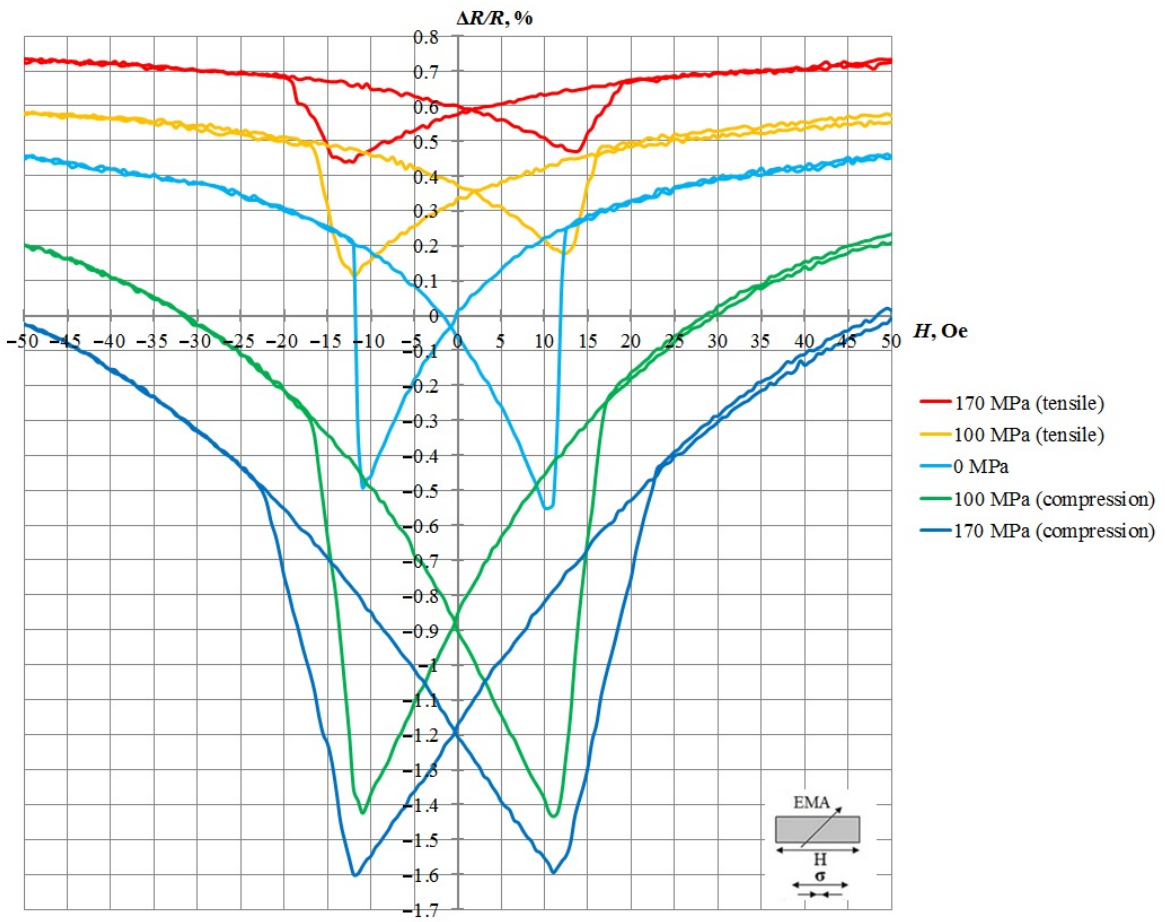
Figure 7. Results of measuring the magnetoresistive effect in the absence and presence of mechanical compression/tension load.